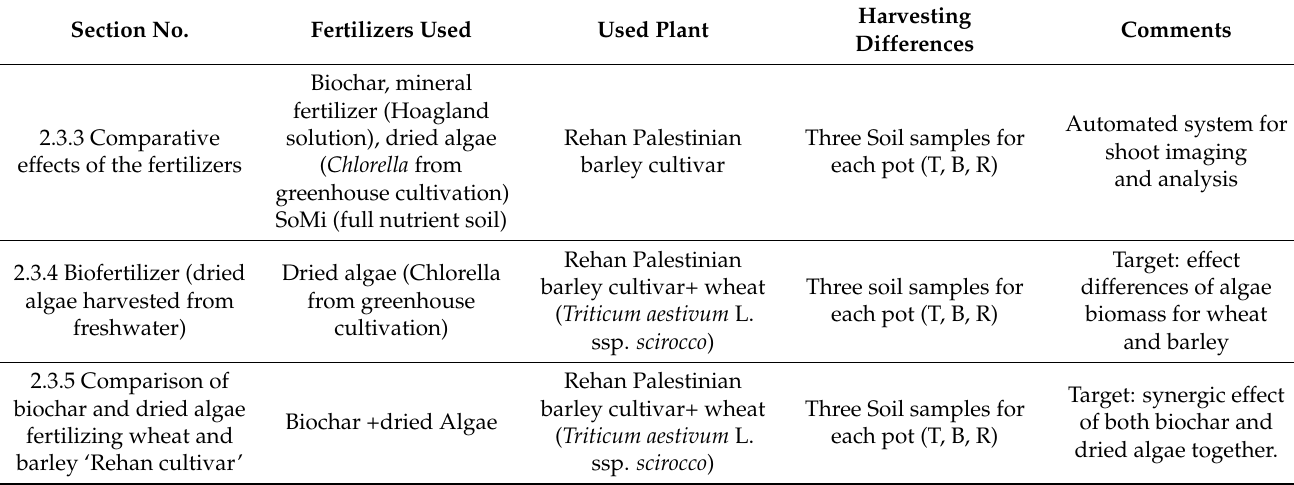
Table 1. Summary of the experimental design of